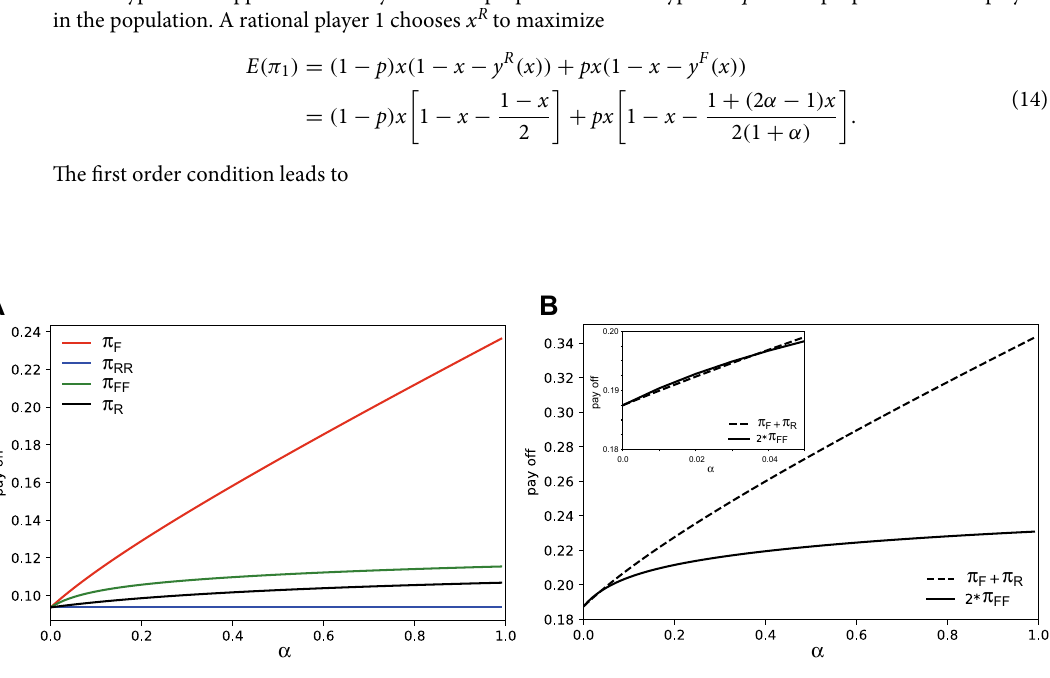
Figure 1. Values of material payoffs for complete information cases. For the comparison of material payoffs, we observe the values of each material payoff ( A ), and ( π F + π R )-vs. 2 ∗ π FF ( B , inset), according to the parameter α